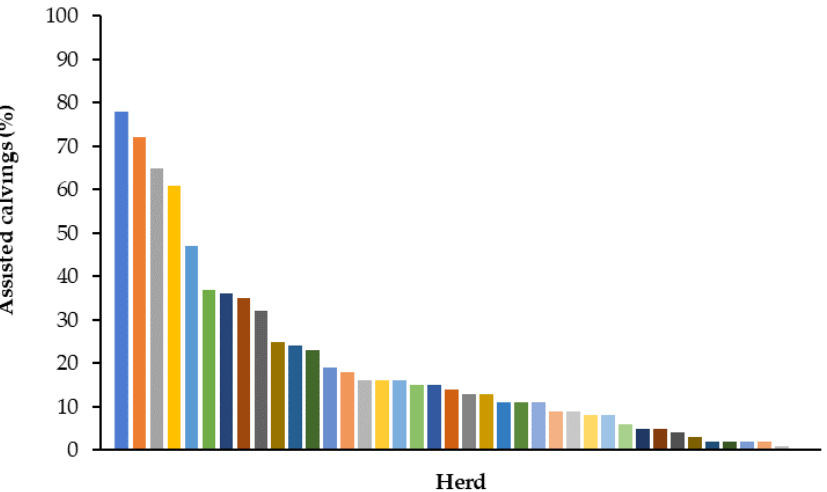
Figure 1. Distribution of assisted calving prevalence in the 40 Italian Holstein cow herds enrolled in the study. Each column corresponds to a single herd. Table 3. Risk factor associations with calving ease.